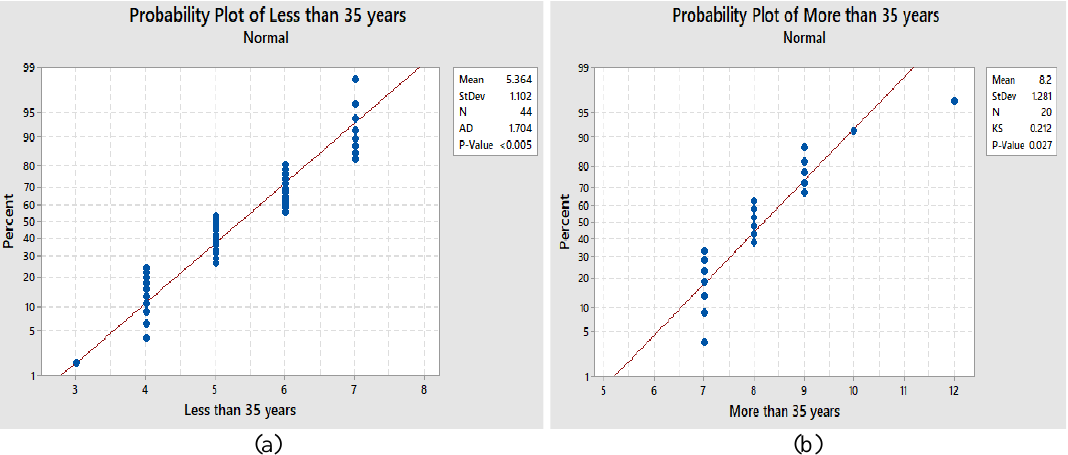
Figure 10. Probability plot for the onboarding process for merchants less than 35 years old (a) and more than 35 years old